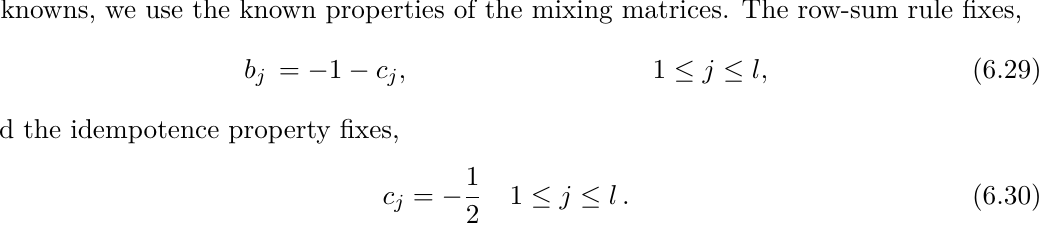
JHEP02(2023)258